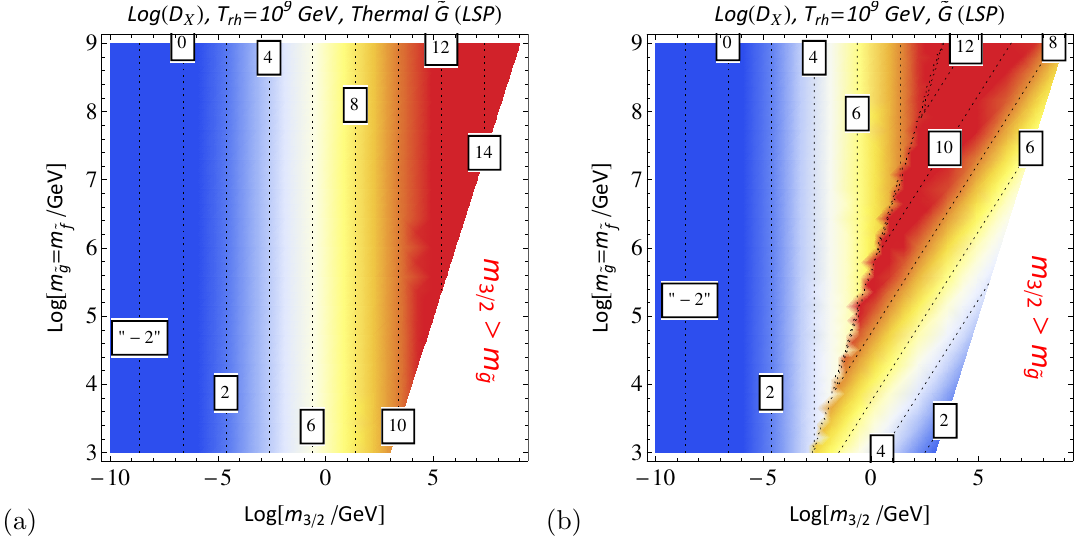
Figure 3 . Density and contour plot of the decadic logarithm of the required dilution for gravitino LSP and reheating temperature T rh = 10 9 GeV. In the left panel the gravitinos are thermal (heavy gravitinos can thermalize due to the messenger sector). In the right panel the contribution of messengers plus MSSM is considered, assuming a small enough messenger coupling so that gravitinos do not thermalize by the interactions with messengers, but only due to the MSSM. The messengers scale is taken to be M mess = 10 8